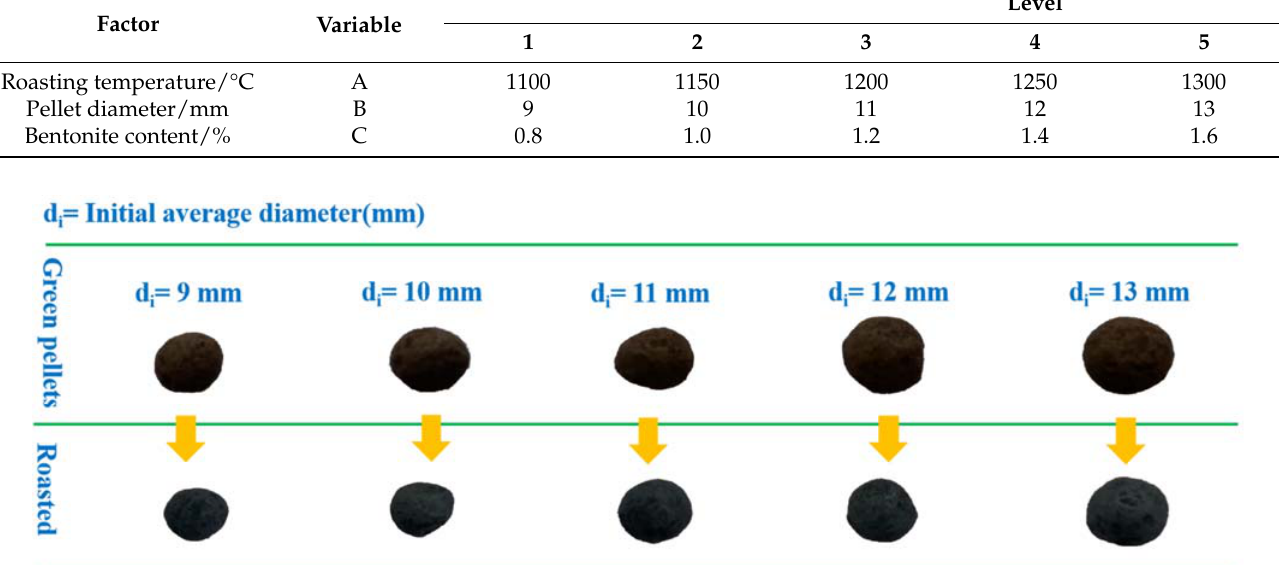
Table 1. Experimental design.